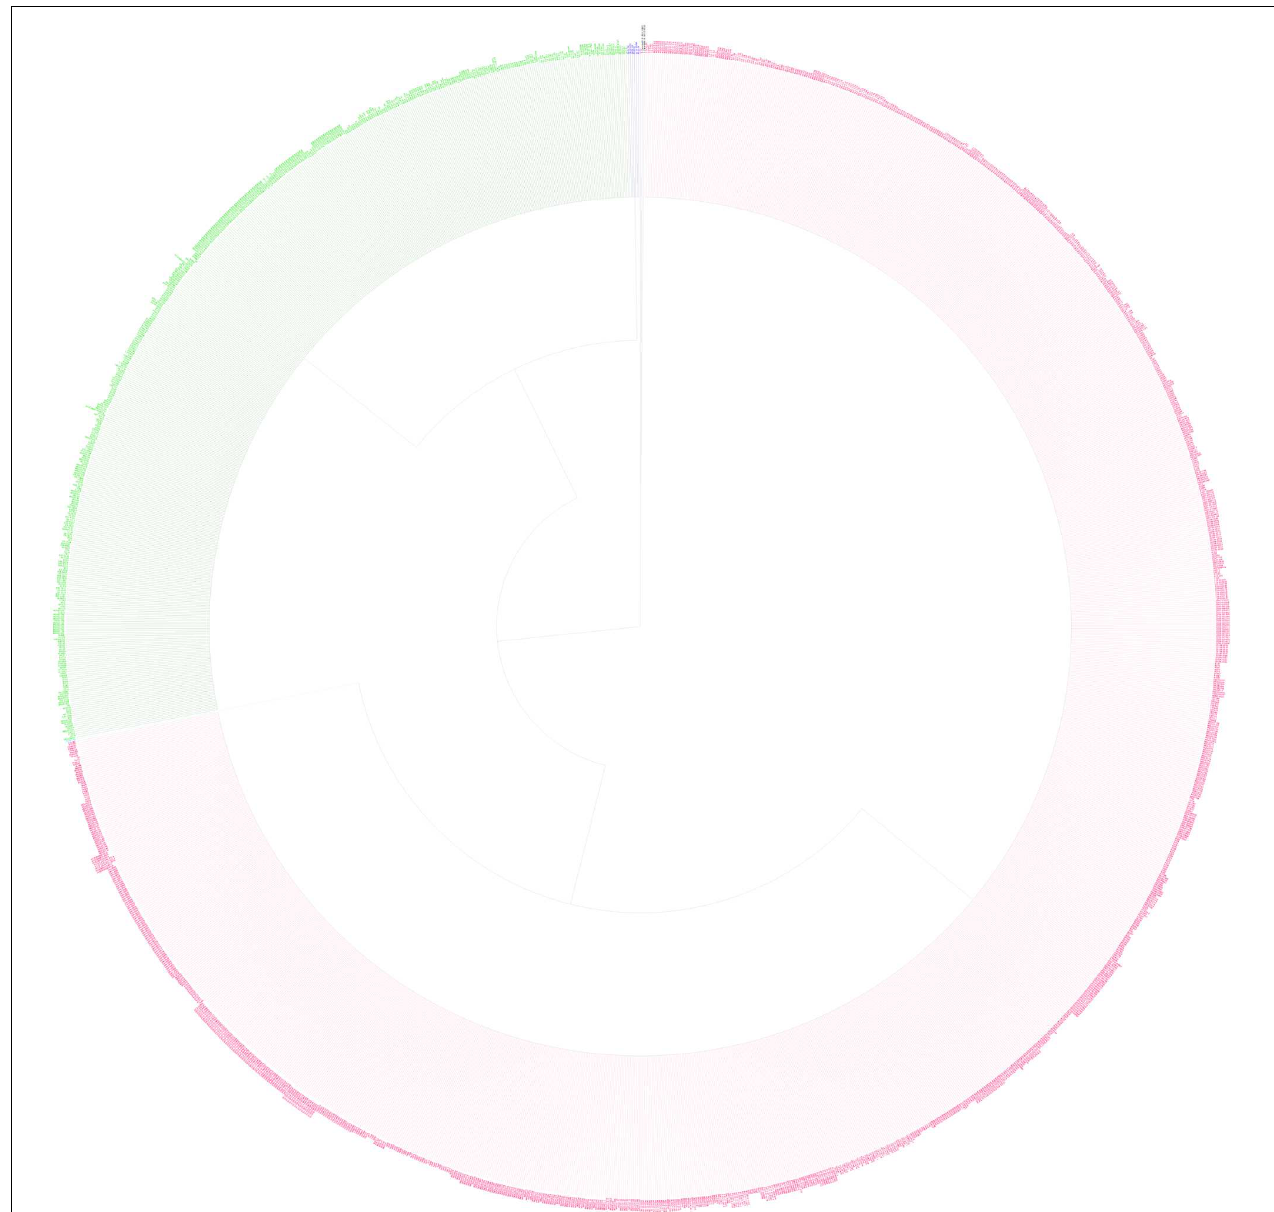
FIGURE 1 | Maximum Likelihood tree shows the genetic relationships of 3,336 bp concatenated MLST genes sequences derived from the seven housekeeping loci of 1,783 S . Typhi strains isolated globally. The tree is rooted with S . Paratyphi A. The colors of the strains label represent the STs; red for ST1, green for ST2, blue for ST8, pink for ST2233, light blue for 2359, and black for outgroup. All branches have more than 90%